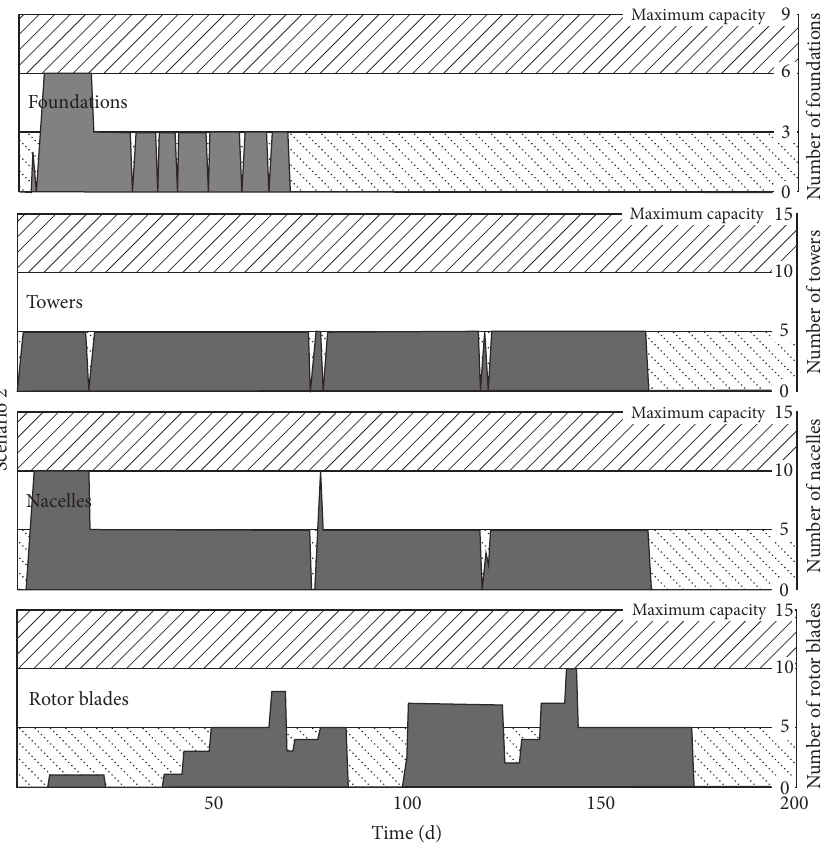
Figure 5: Simulation results of Scenario